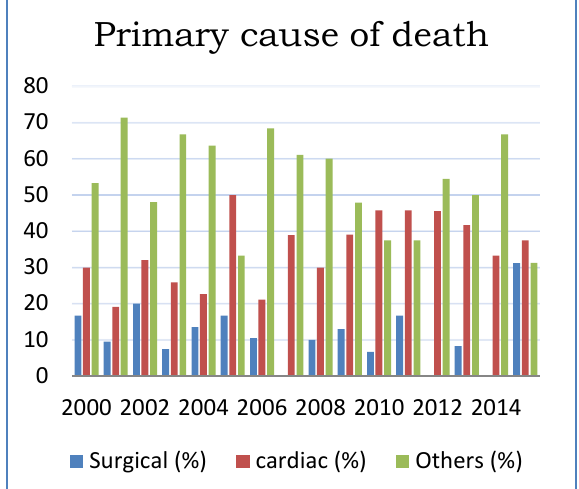
Figure 4- Trends in primary cause of death over the study period Lillehei et al estimated in-hospital mortality for ne- onates undergoing non-cardiac surgery as 2% in term infants and 10.5% in preterm infants